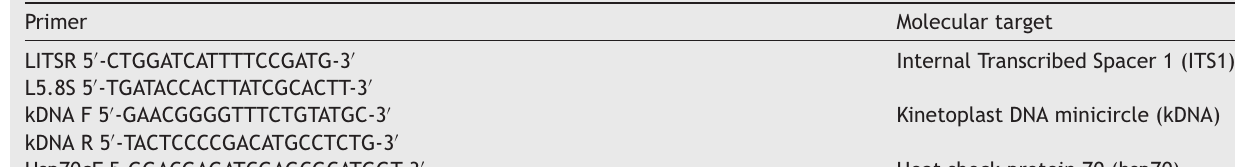
Description of primers used for DNA detection of Leishmania . Primer Molecular target LITSR 5 (cid:3) -CTGGATCATTTTCCGATG-3 (cid:3)